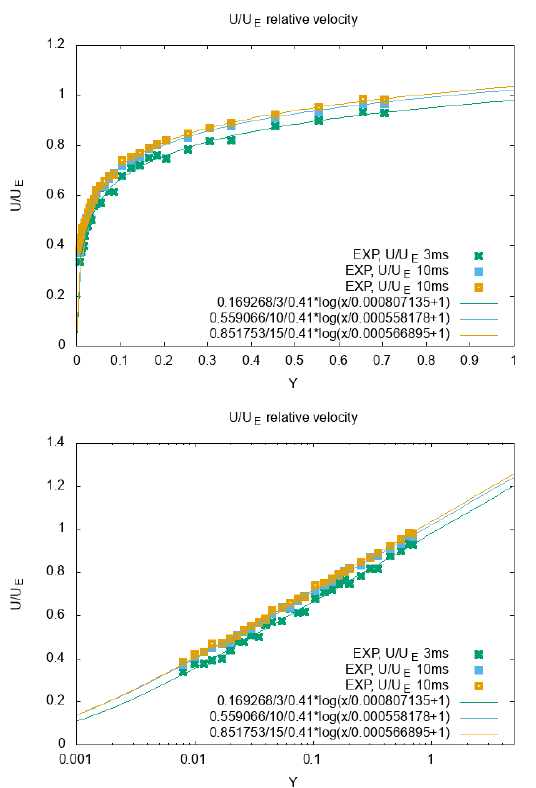
Fig. 2. The flow over rough plate: measured relative veloc- ity profile, and estimate by the logatithmic profile U ( y ) / u τ = + 1). Constants u 1 lo g ( y τ , z S were computed using the least- z S κ squares approximation of measured data. Velocity regimes U E = 3 m · s − 1 , 10 m · s − 1 and 15 m · s − 1 .